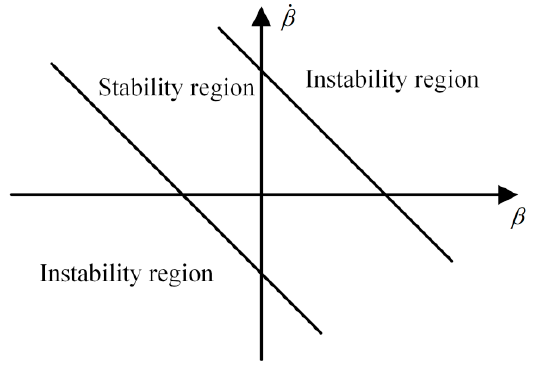
Figure 5. Sideslip angle phase plane division region.